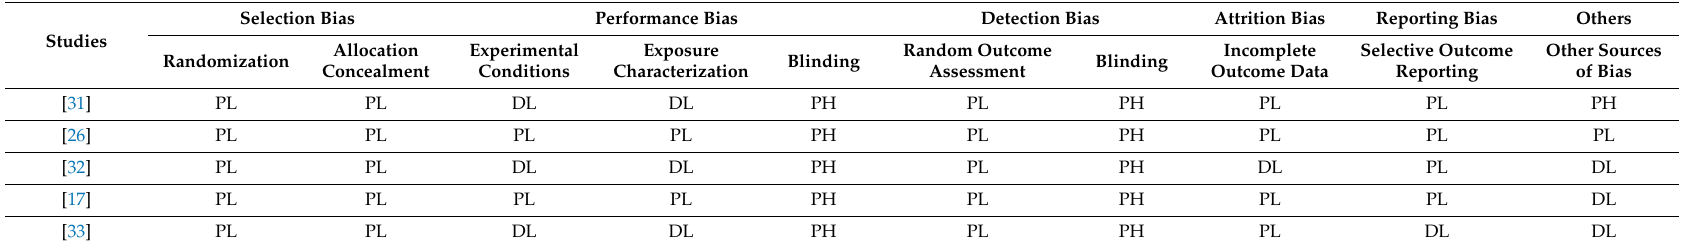
Table 2. Risk of bias assessment for in-vitro studies using the modified OHAT